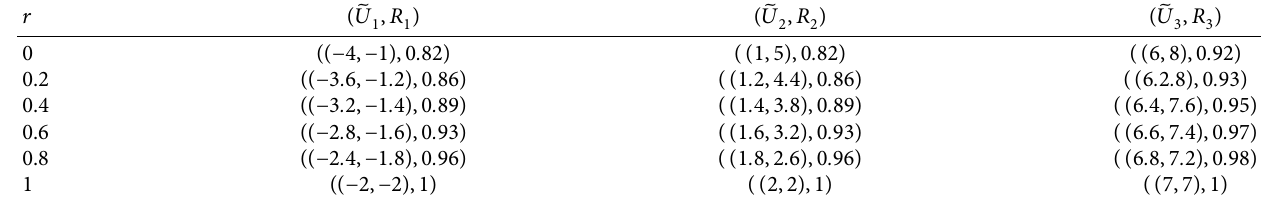
Table 8: Te diferent values of [ U ] Z for λ � 0 . 05 and r � 0 , 0 . 1 , ... , 1.